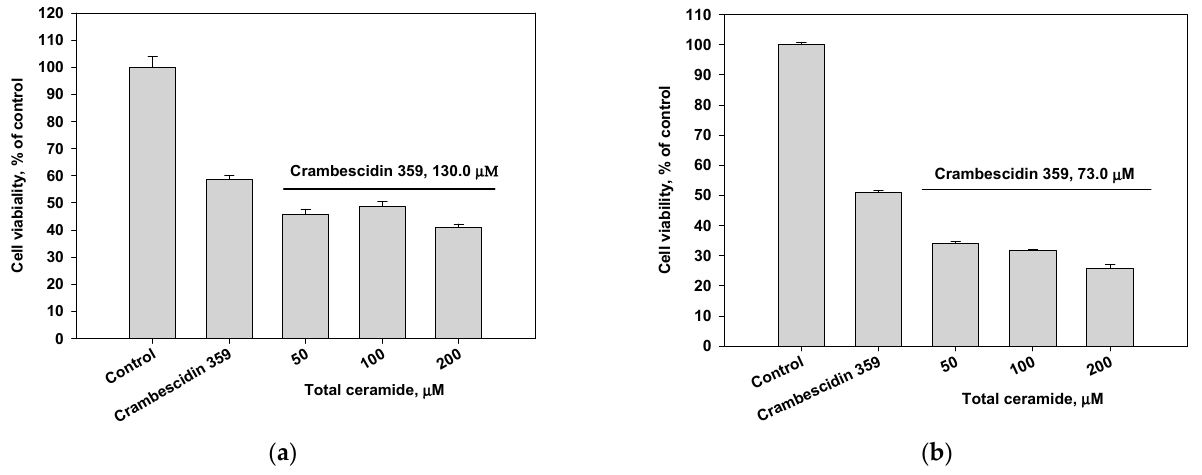
Figure 3. Cytotoxic effects of crambescidin 359 (IC 50 concentration) in combination with total ceramide (various concentrations) on ( a ) MDA-MB-231 and ( b ) HL-60 cell lines.